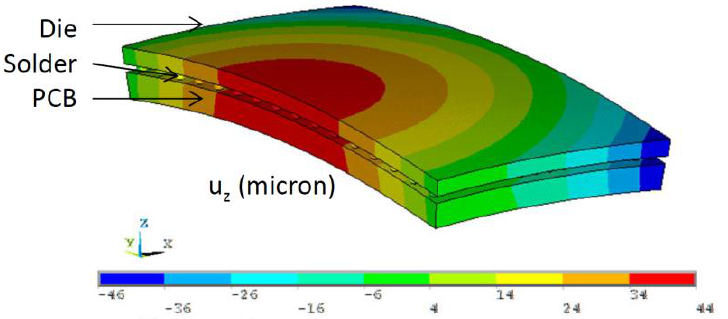
Figure 10. Deformed shape of global model.